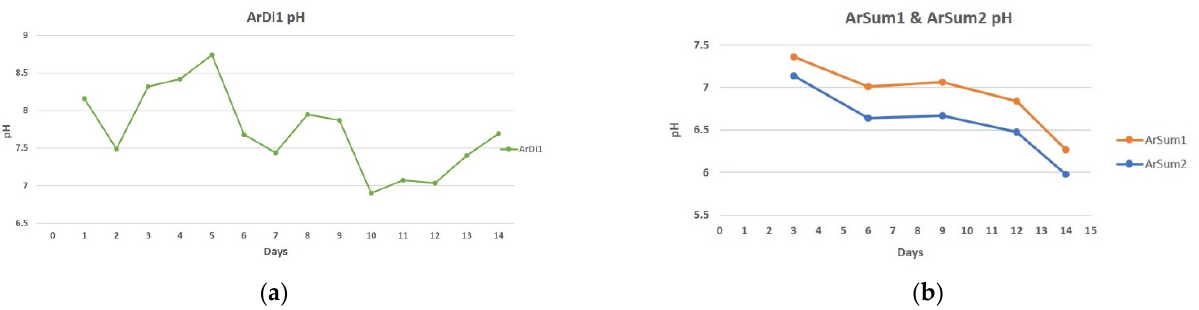
Figure 6. pH values of ( a ) sample ArDi1 drain outlet, and ( b ) sample ArSum1, ArSum2 and no bacteria control sample drain outlet.